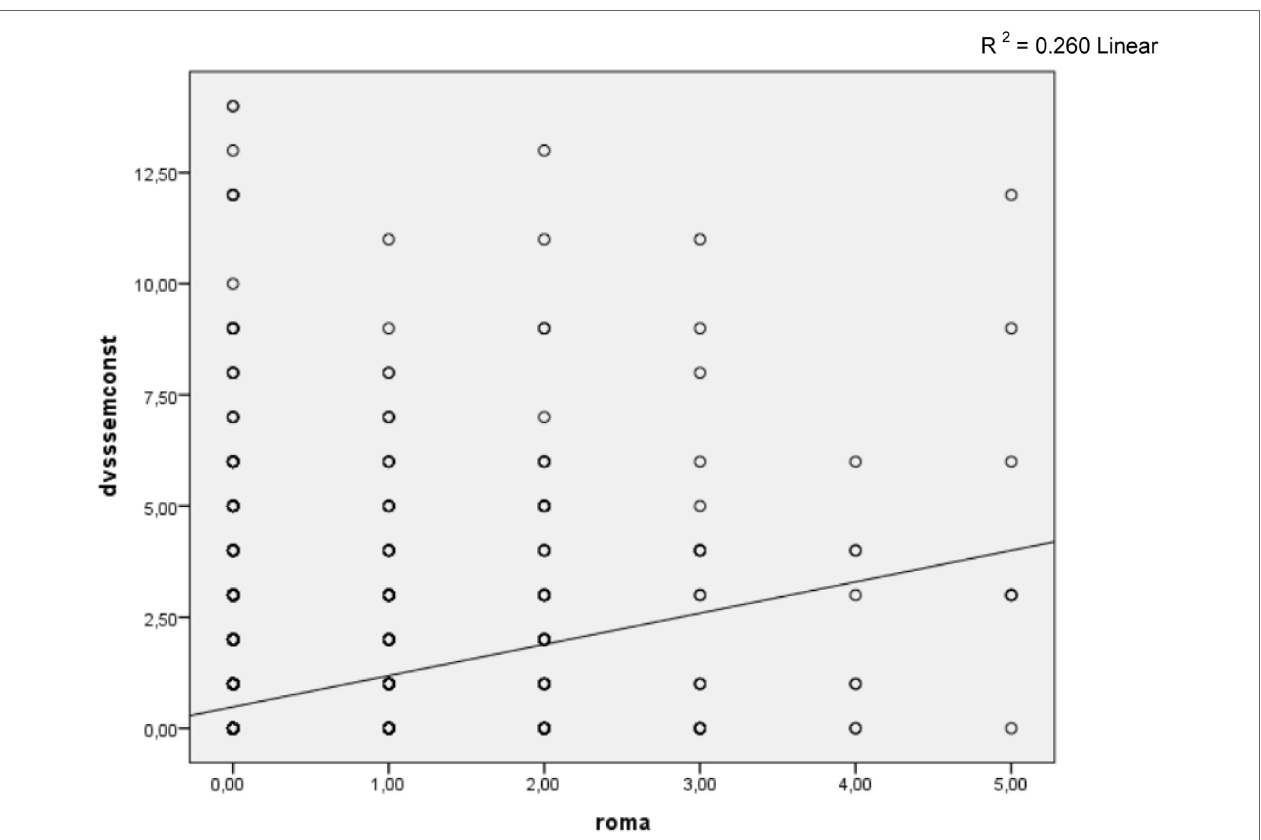
FigUre 1 | spearman correlation between DVss score (disregarding questions related to intestinal rhythm) and rome iii criteria . R 2 = 0.260